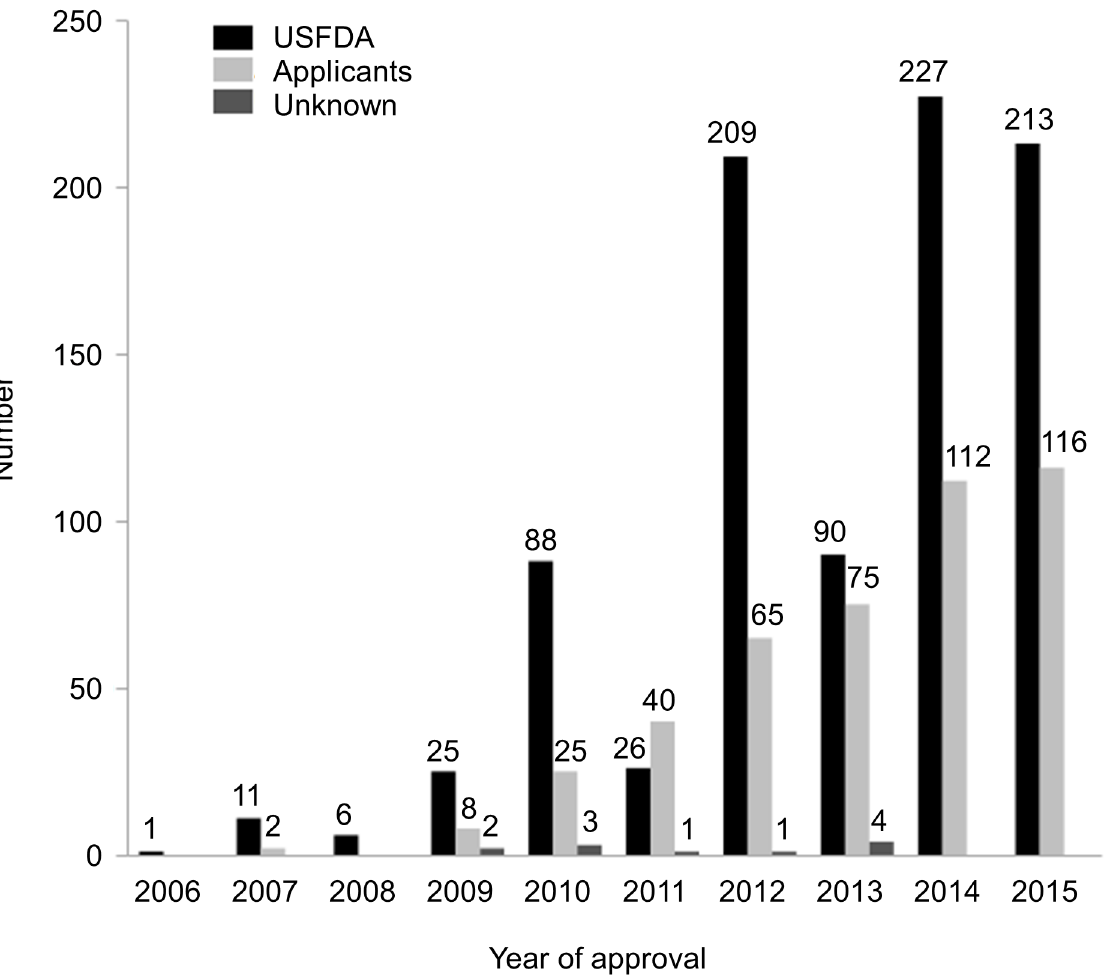
Fig 3. The numbers of SMQ searchesinitiated by the USFDA and applicants per year of approval. SMQ, Standardised MedDRAQuery; USFDA, United States Food and Drug Administration.